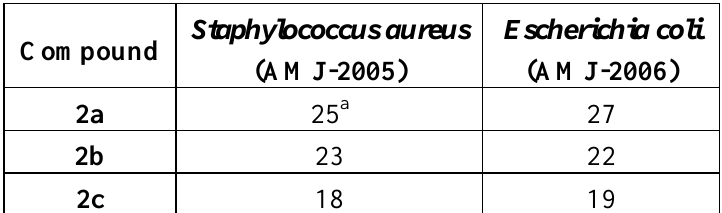
Table1 Bacterial Inhibition Zone